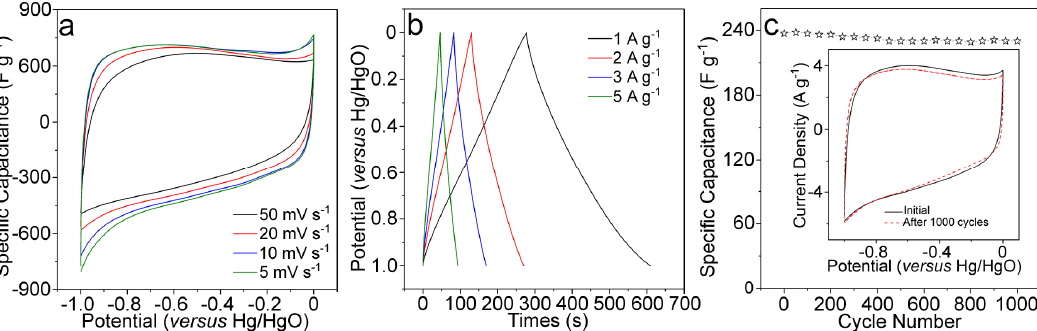
Figure 6. ( a ) CV curves of the as-prepared MPC electrode at different scan rates; ( b ) Charge/discharge curves of the as-prepared MPC electrode at different current density; ( c ) Cycle performance of the MPC electrode at current density of 5.0 A g −1 .